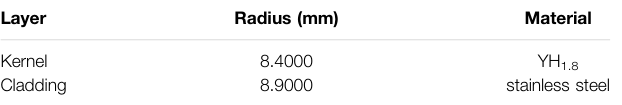
TABLE 4 | YH 1.8 solid moderator pin geometry and